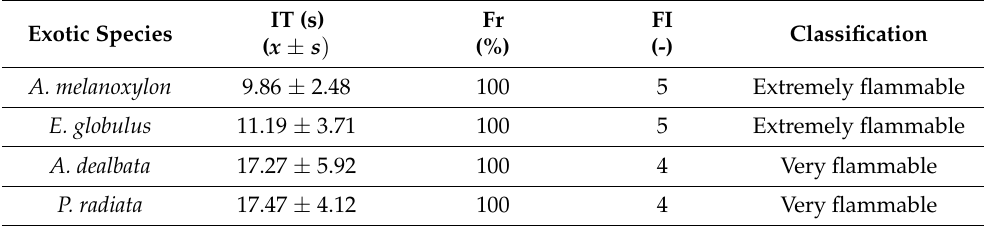
Table 2. Classification of the flammability of exotic species according to the flammability index (FI), based on the average ignition time (IT) and ignition frequency (Fr). IT (s) Exotic Species ( x ± s